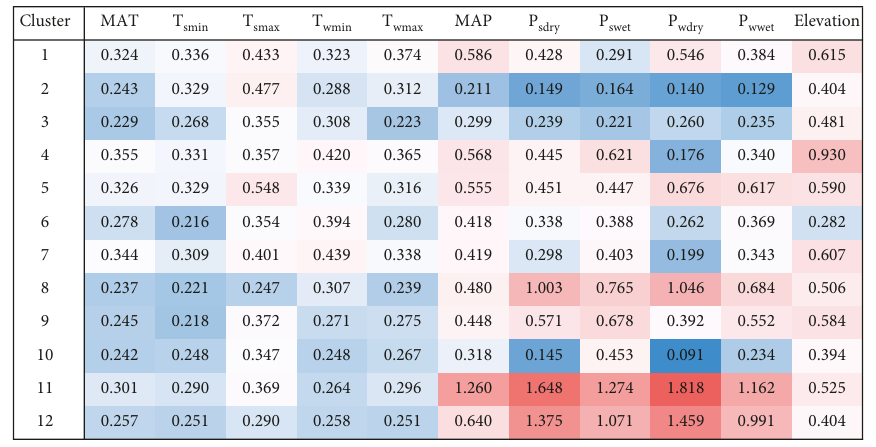
Figure 13: Standard deviation of the normalized variables in each cluster of k -means 12-cluster solution.